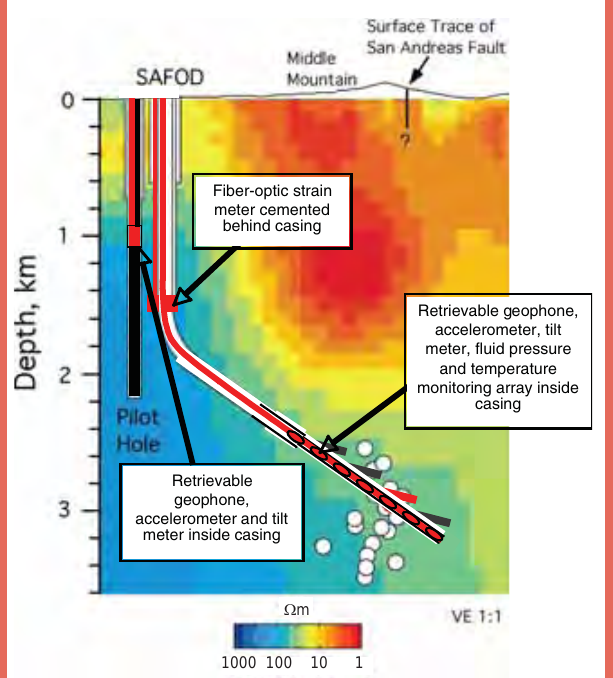
Figure 4. Scheme of SAFOD observatory. Seismic and tilt instru- mentation is being deployed in the pilot hole. A fi ber optics strain meter is installed behind the casing in the vertical section of the main hole. An array of seismometers, accelerometers and tiltme- ters are being developed for deployment in the main hole.